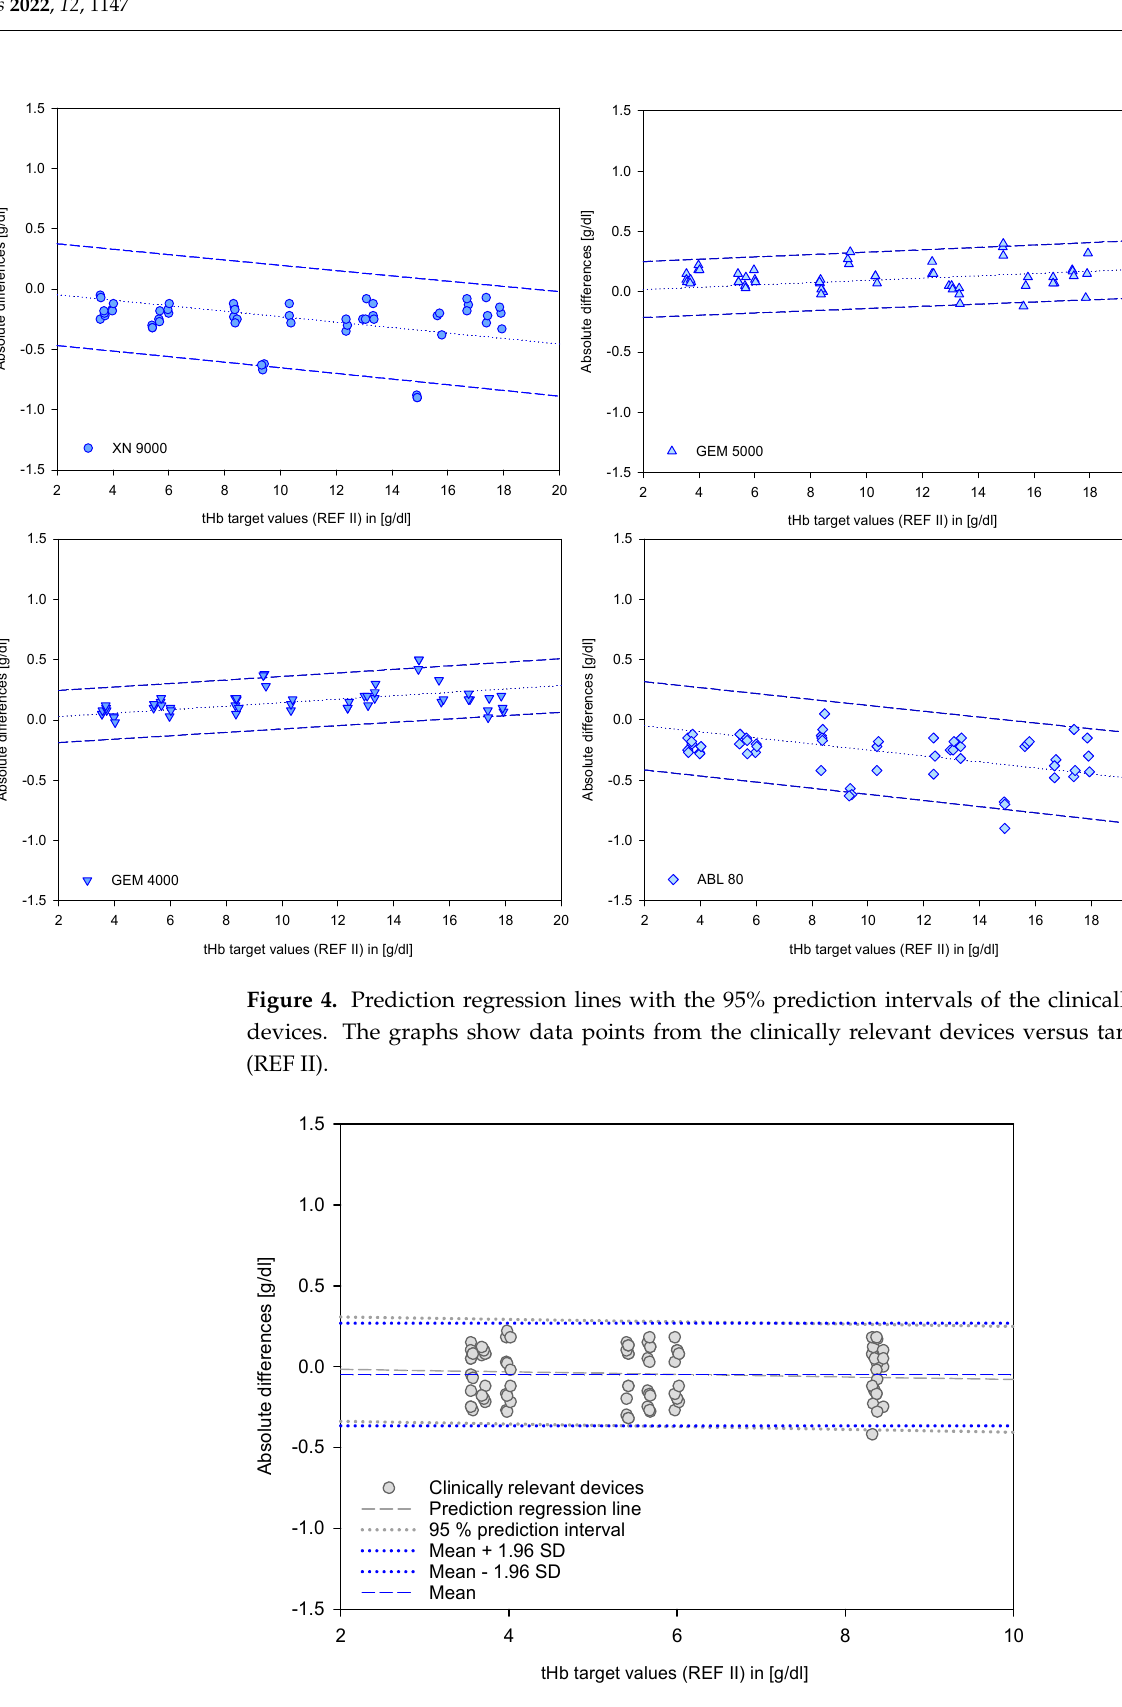
Figure 5. Absolute differences for the tHb segment below 9 g/dL for the clinically relevant devices against target values (REF II). The graph shows overlapping of B and A definitions with the 95% prediction interval.